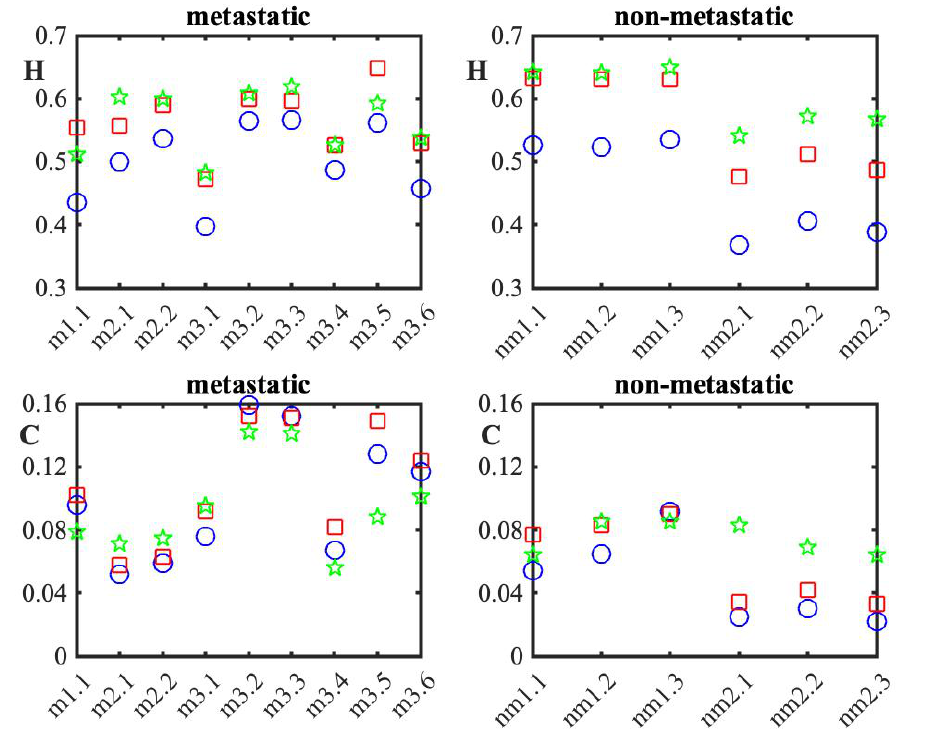
Figure A5. The obtained generalized Hurst exponent, H , and the co-dimension parameter, C , for Figure C5. The obtained generalised Hurst exponent, H , and the co-dimension parameter, C , for two-dimensional analysis as well for analysis in separate x and y axes for M and NM histological two dimensional analysis as well for analysis in separate x- and y- axes for M and NM histological cross-sections. Color code: blue for surface analysis; red for analysis in x axis; and green for analysis cross-sections. Color code: blue for surface analysis, red for analysis in x-axis, and green for analysis in the y in y-axis. cells, C is constantly smaller for the surface than the corresponding values for scaling in x- and y-axes. On the other hand, for M cells, the values of C for both surface analysis and for individual analysis on the x- and y- axes, do not show any systematic trend.